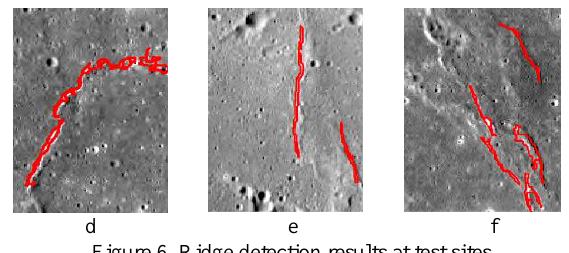
Figure 3. DEM data at test sites